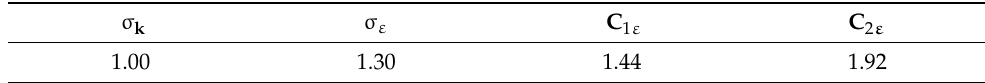
Table 1. Turbulence model